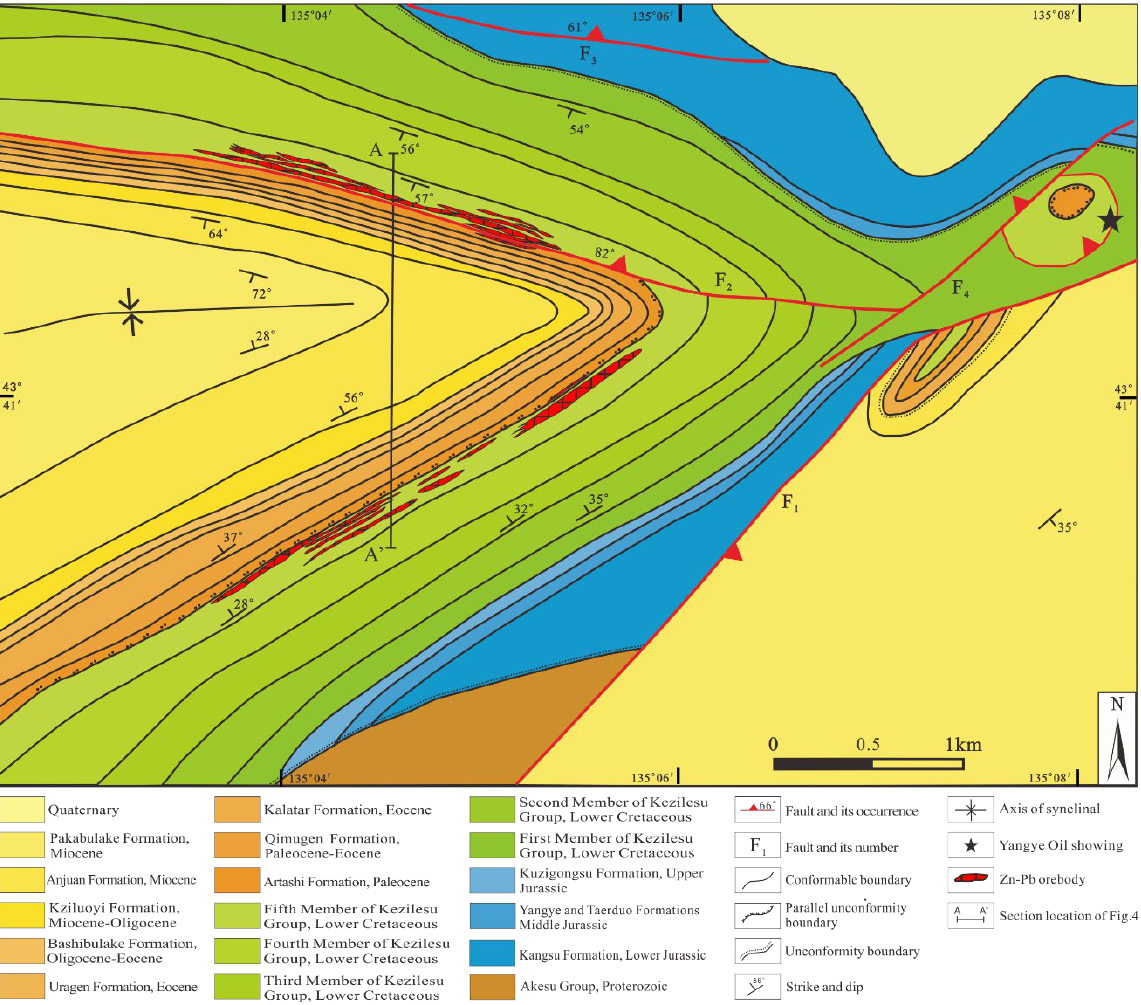
Figure 2. Geological map of the Uragen Zn–Pb deposit and surrounding area (modified after [17,24]). The location of profile A–A’ has been outlined. The deposit is divided into northern and southern ore zones by the axis of the east/west- trending Uragen syncline (Figures 2 and 3). The northern ore zone has an average thick- ness of ~100 m, a trending length of more than 3.5 km and grades of 0.03–0.47% Pb and 2.24–3.41% Zn [17]. The southern ore zone has an average thickness of ~150 m, a trending length of more than 4.0 km and grades of 0.23–0.89% Pb and 1.69–3.64% Zn [17]. The orebodies are stratiform, tabular and developed on both limbs of the Uragen syncline (Figure 2), as well as in the hinge area at depth (Figure 3), where Zn–Pb mineralization was detected by the deepest drill holes, indicating that the two ore zones are connected spatially (Figure 3)